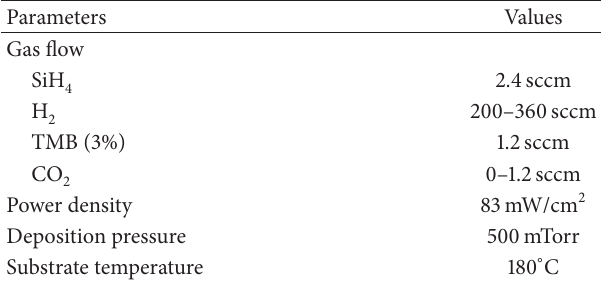
Table 1: Deposition condition for p- 𝜇 c-Si 1−𝑥 O 𝑥 :H